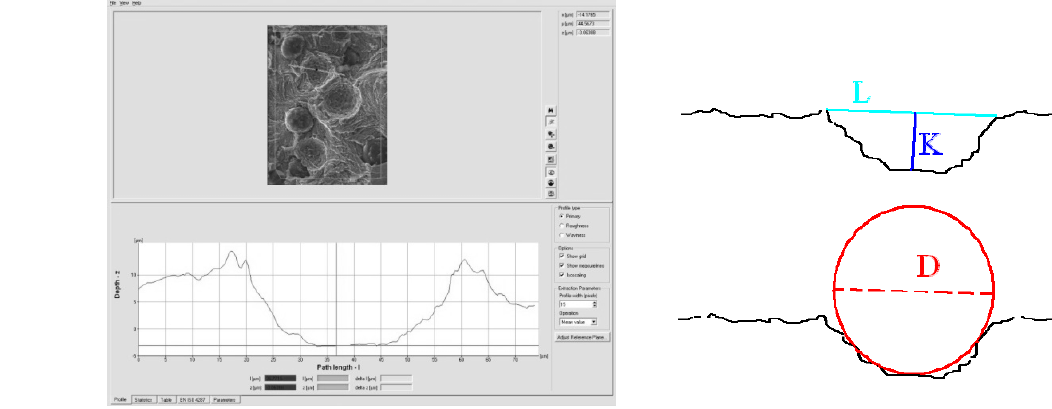
Figure 10: Fracture surface profile quantitative analysis. Figure 11: Geometrical parameters used in the surface